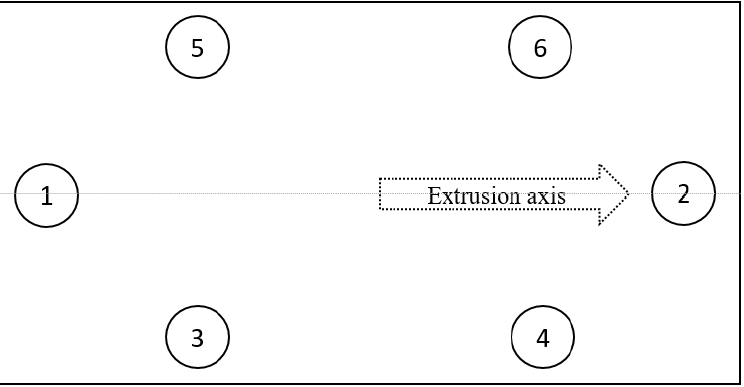
Figure 2. Schematic diagram showing different locations from where the measurements were taken out to obtain the average thickness of the sheets.